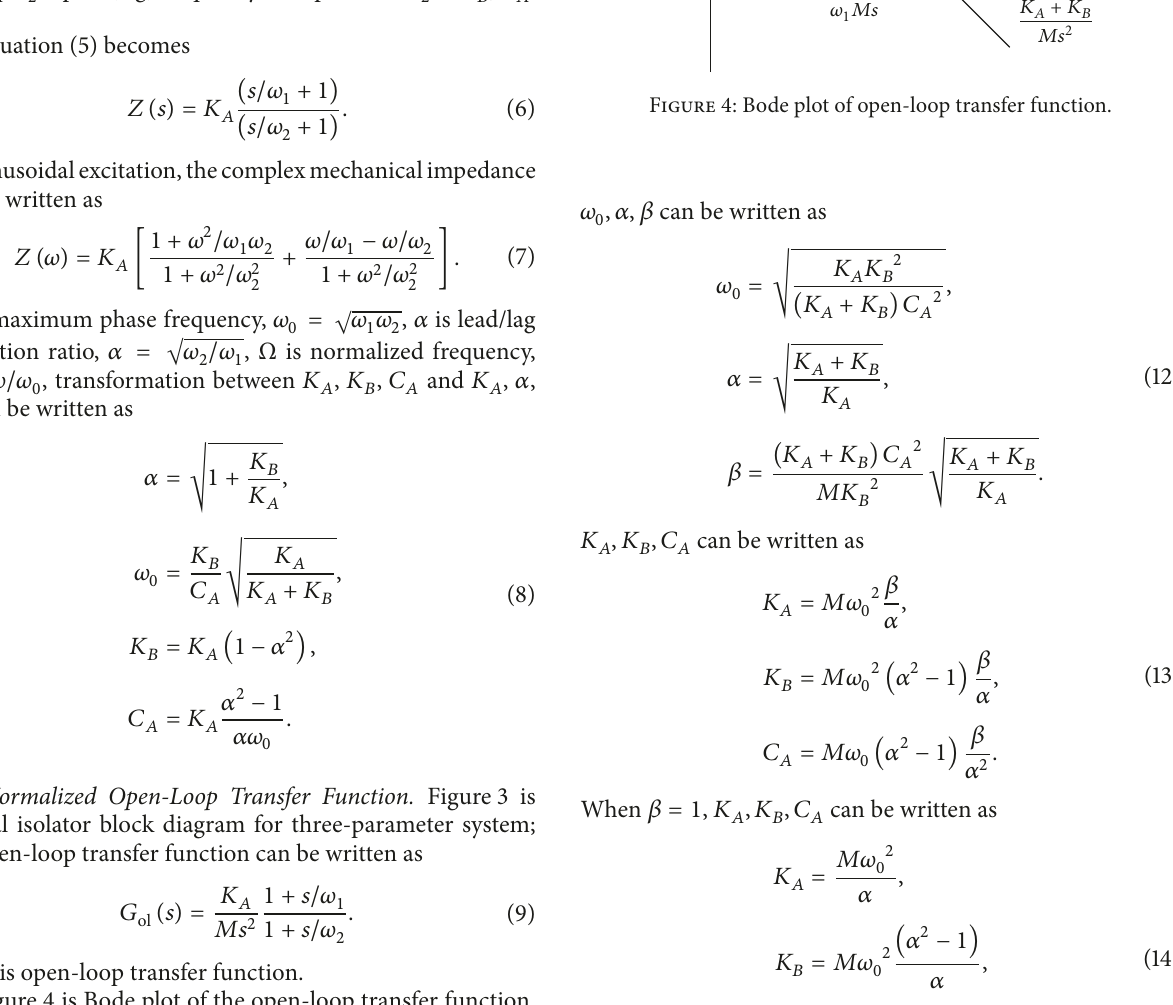
Figure 4 is Bode plot of the open-loop transfer function.